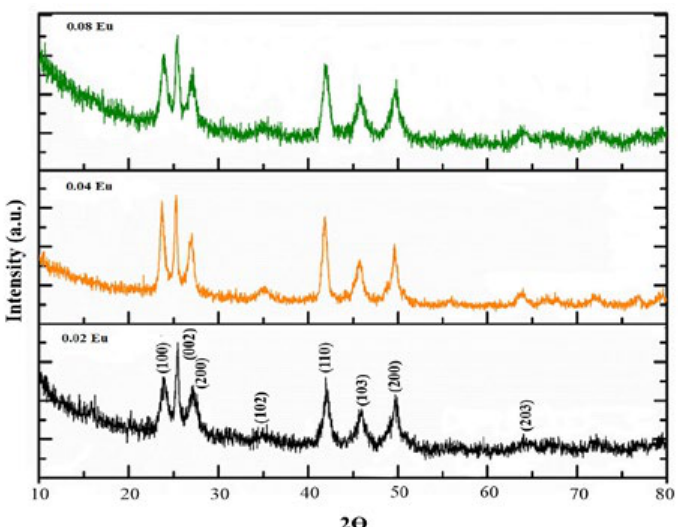
Fig. 1. Powder X-ray diffraction pattern of Eu x Cd 1−x Se ((a) x = 0.02, (b) x = 0.04, (c) x = 0.08)